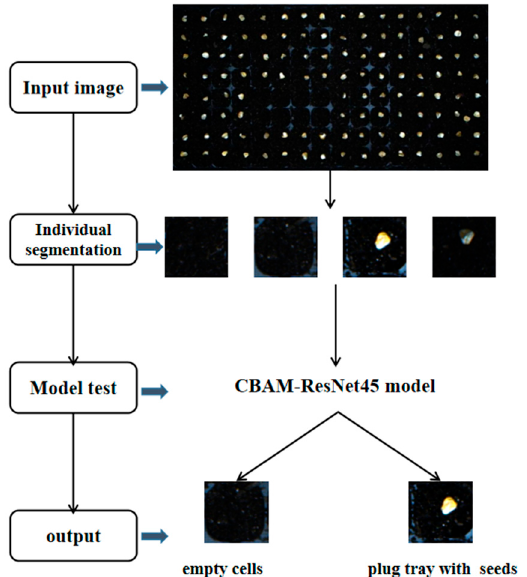
Figure 8. The model testing process.